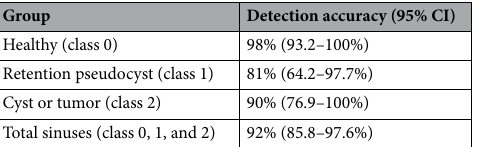
Table 2. Performance of the model for maxillary sinus classification. CI Confidence interval.